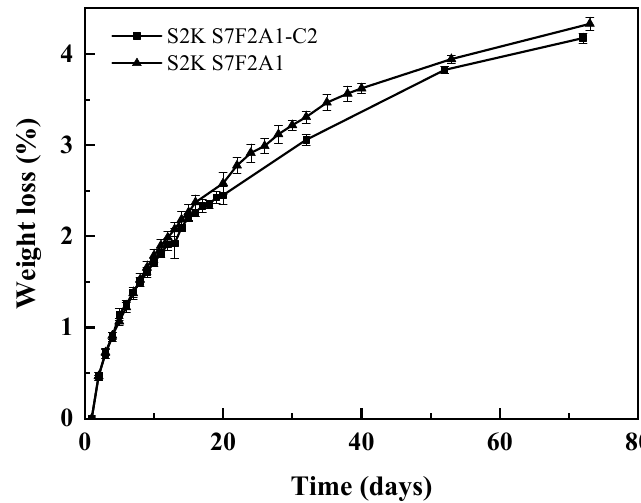
Figure 10. Mortars’ weight loss vs . curing days.